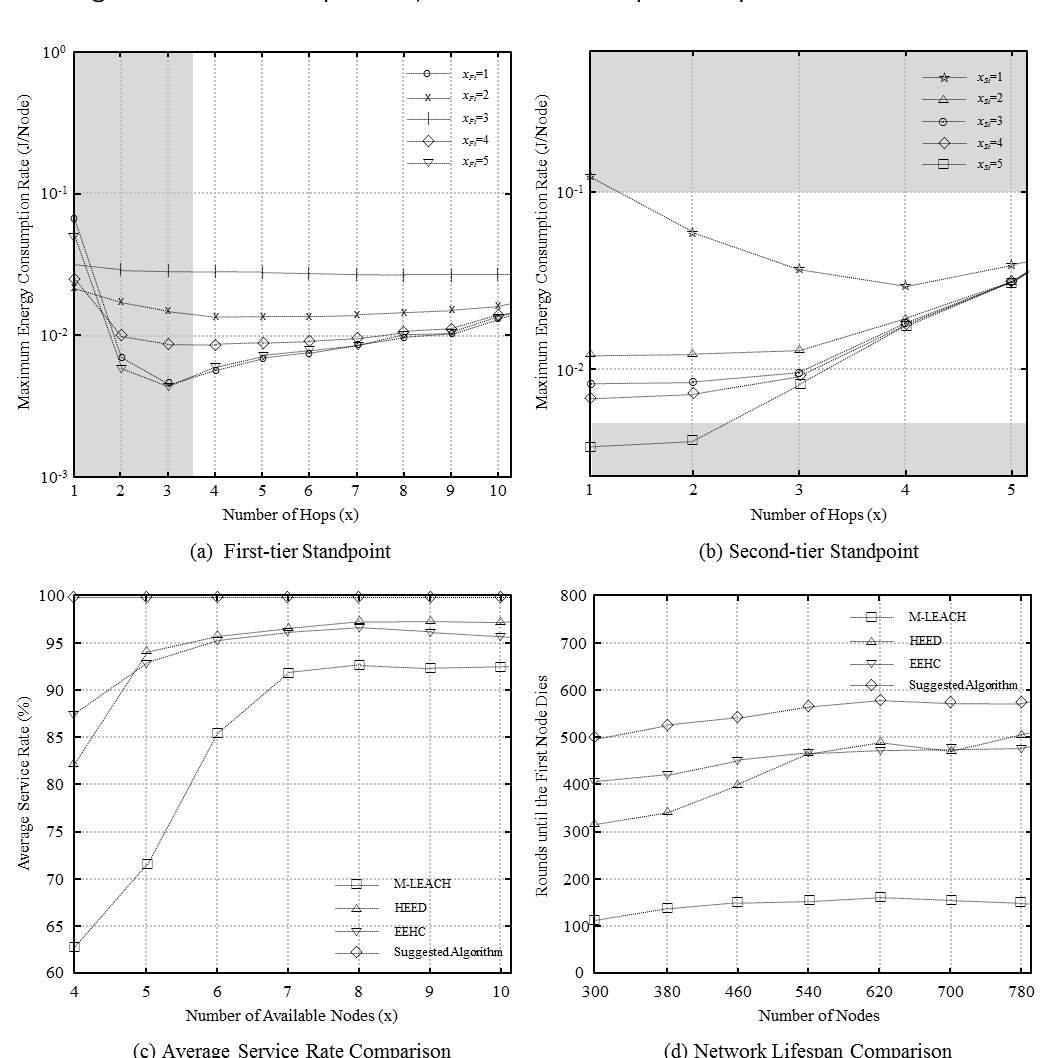
Figure 3. Performance evaluation. ( a ) First-tier standpoint; ( b ) Second-tier standpoint; ( c ) Average service rate comparison; ( d ) Network lifespan